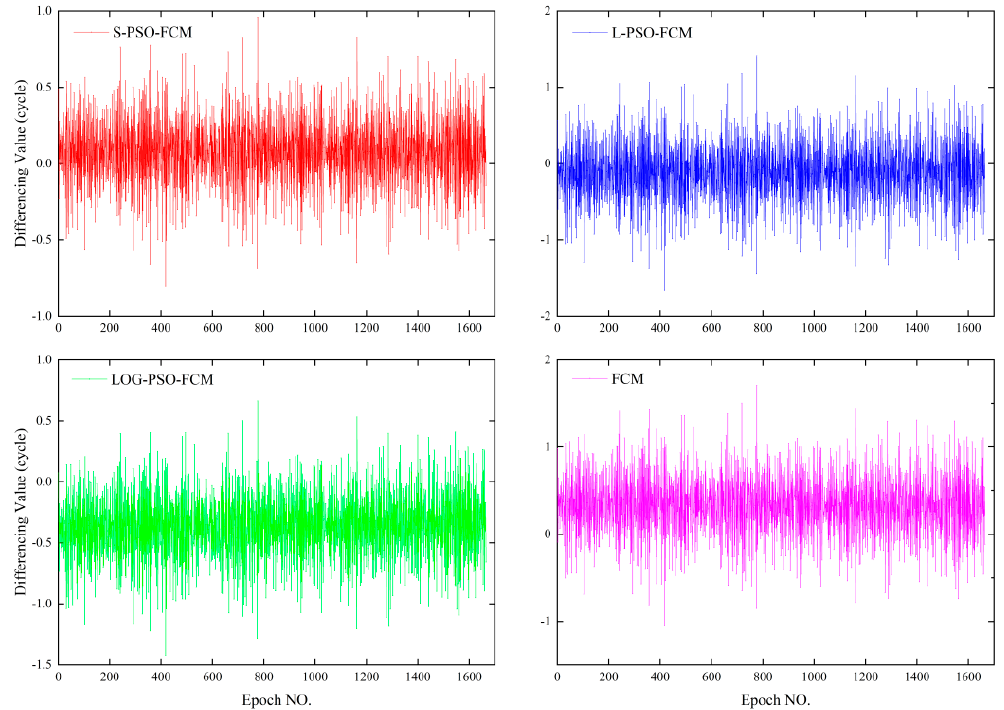
Figure 10. Differencing values calculated by four algorithms under the long baseline